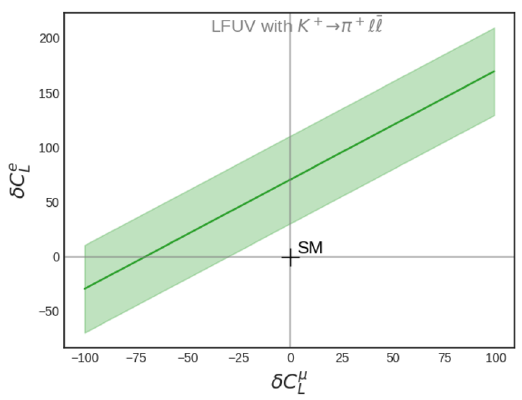
Figure 2 . Region consistent with the estimation of the LFUV variable in K + → π + ‘ ¯ ‘ decays. freedom), the non-universality can be explained by a broad range of values. However, a